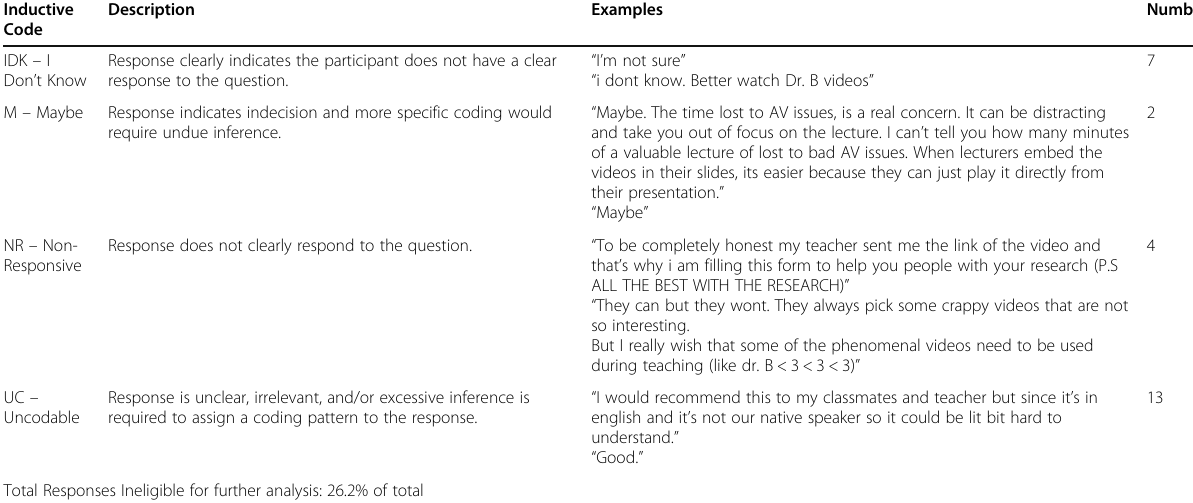
Table 5 Primary Coding Scheme: Coded Responses Ineligible for Primary Codes Inductive